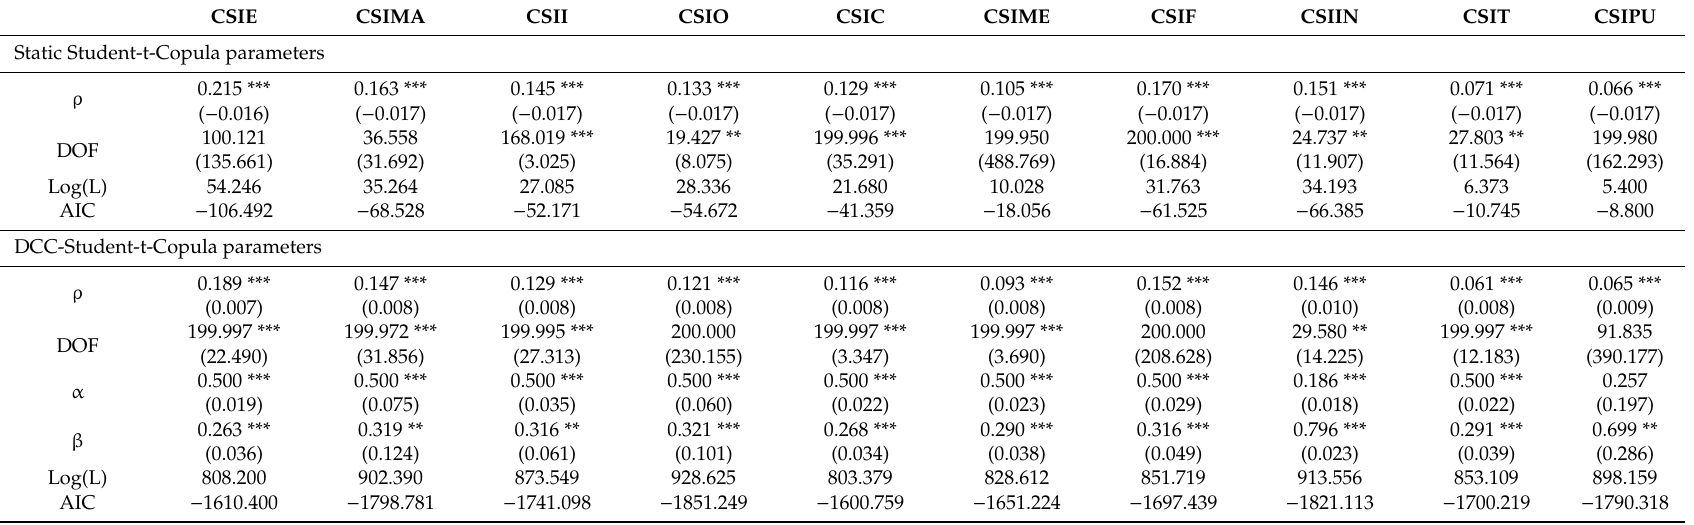
Table A3. Estimates of t-Copula for mid-term trend between Brent spot price and the stock indexes of China Securities